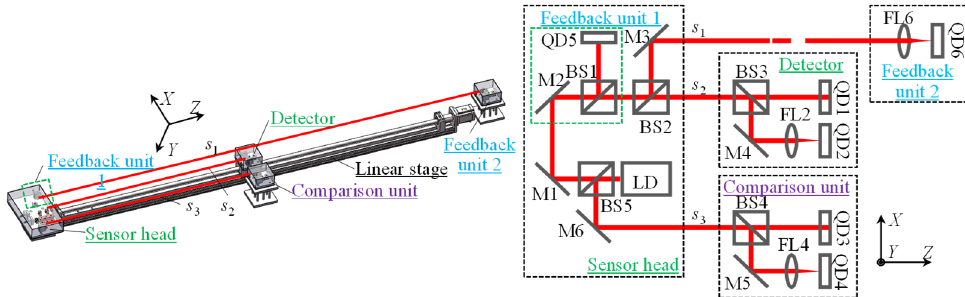
Figure 9. Experimental setup of the LD-based measurement system with the IAEC.